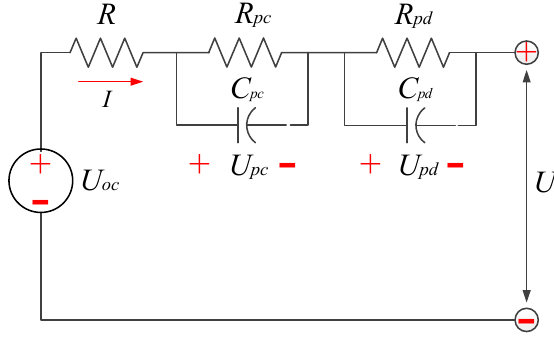
Figure 1. Second order equivalent circuit